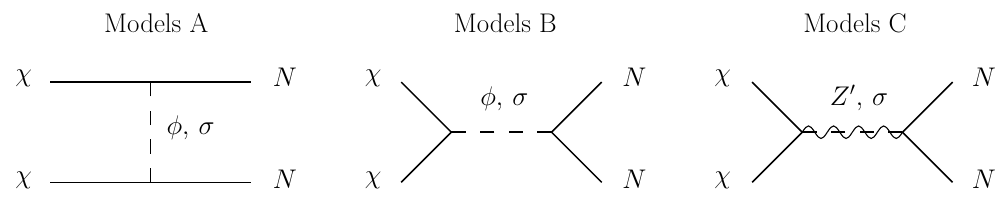
Figure 3 . Diagrams for DM annihilation into sterile neutrinos in the three types of renormalisable models considered. φ and σ stand for a real and complex singlet scalar, respectively, whereas Z 0 is a vector mediator. In Models A, the mediator, exchanged in the t -channel, is charged under the Z We termed these models genuine , as they generate only the four-fermion effective operators with sterile neutrinos and